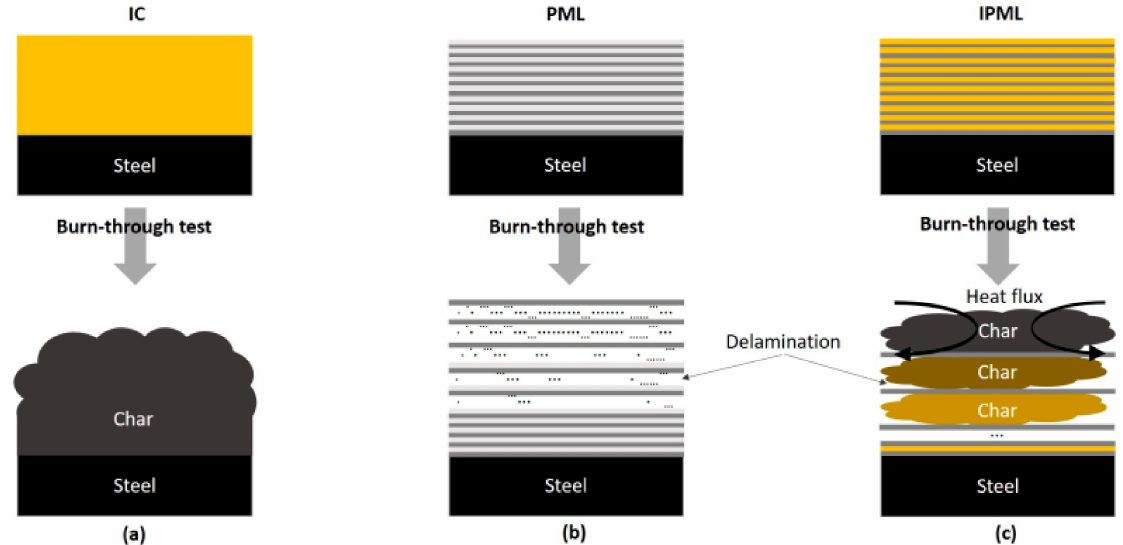
Figure 15. Illustration of the thermal behavior when (( a ) IC, ( b ) PML, and ( c ) IPML) are exposed to a high heat flux fire